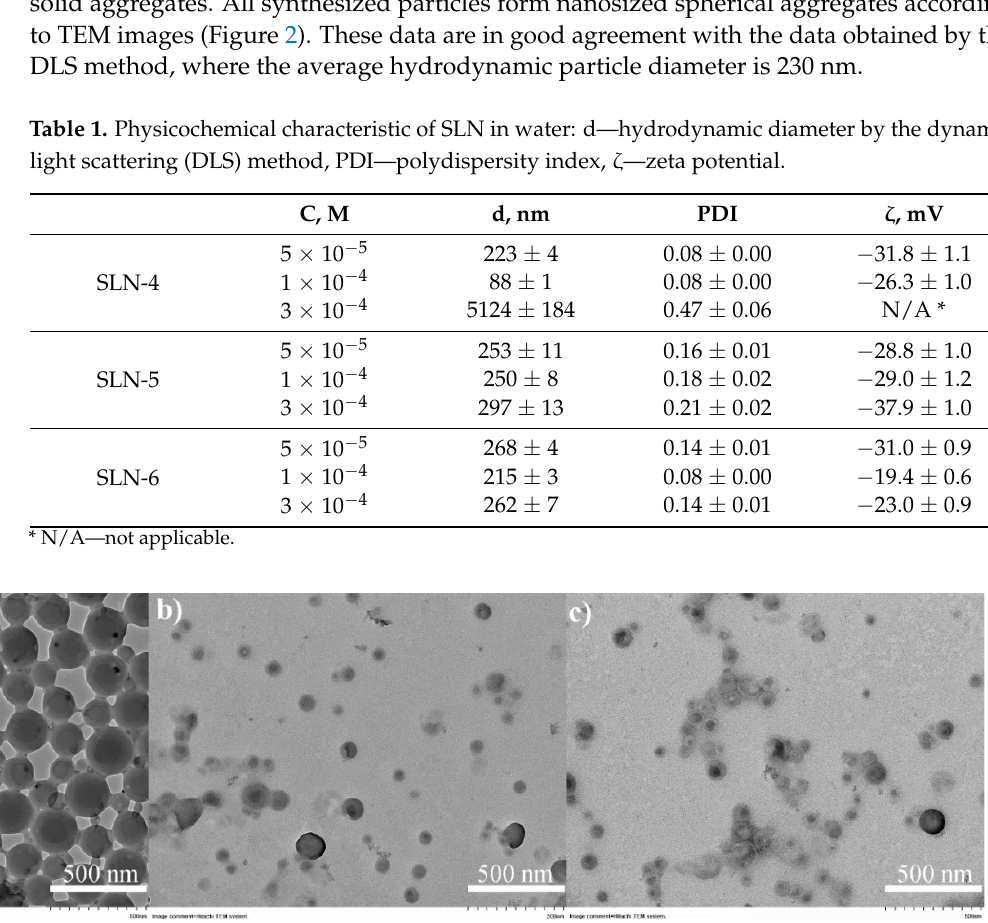
Table 1. Physicochemical characteristic of SLN in water: d—hydrodynamic diameter by the dy- namic light scattering (DLS) method, PDI—polydispersity index, ζ —zeta potential.